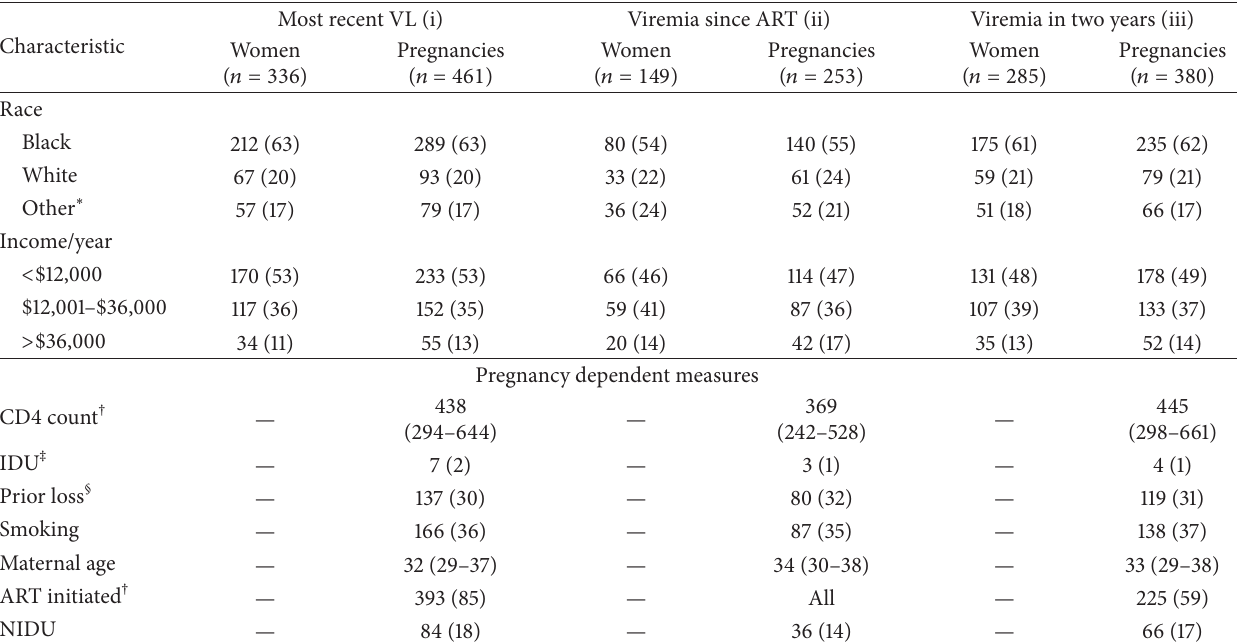
Table 1: Characteristics of HIV-infected women enrolled in the Women’s Interagency HIV Study (WIHS) from October 1, 1994, to March 31, 2013, and their respective pregnancies meeting eligibility criteria for three analytic populations: (i) most recent viral load before pregnancy outcome, (ii) copy-years viremia since ART initiation, and (iii) copy-years viremia in the two years before